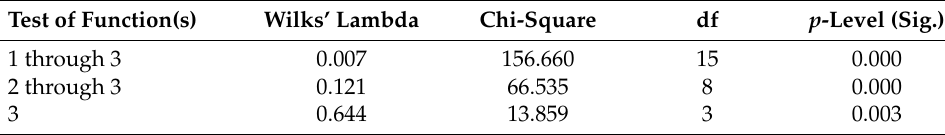
Table 9. Wilks’ Lamda and Chi-square test for the discriminant analysis.